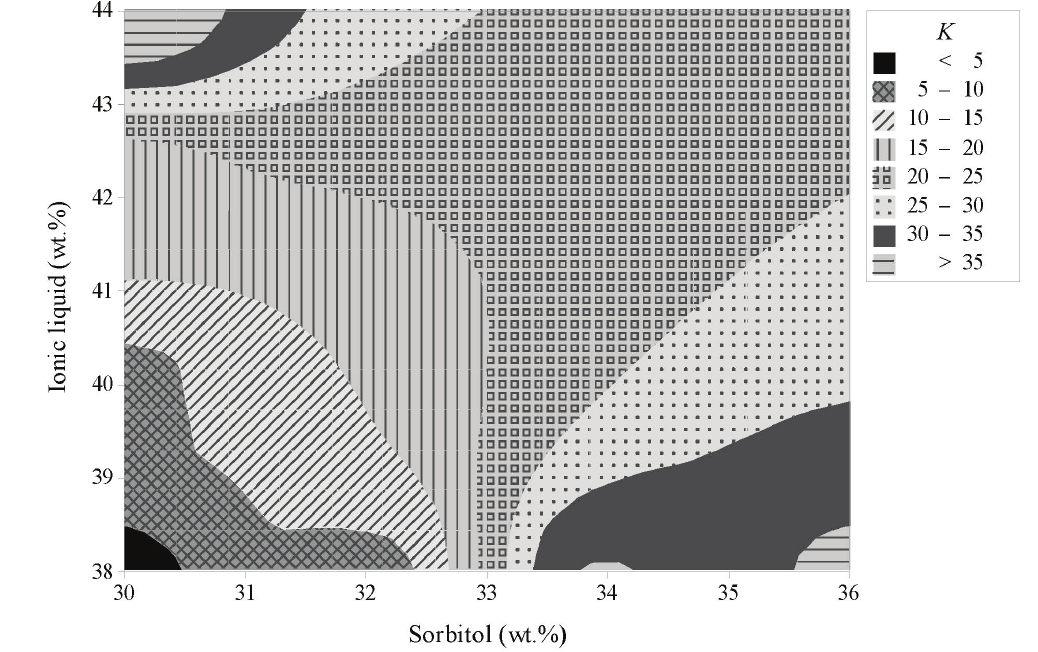
Fig. 2 – Counter plot on the partition coefficients of crocin with the combined effects of weight percentage of the IL and sorbitol of the ATPS containing sorbitol + [P